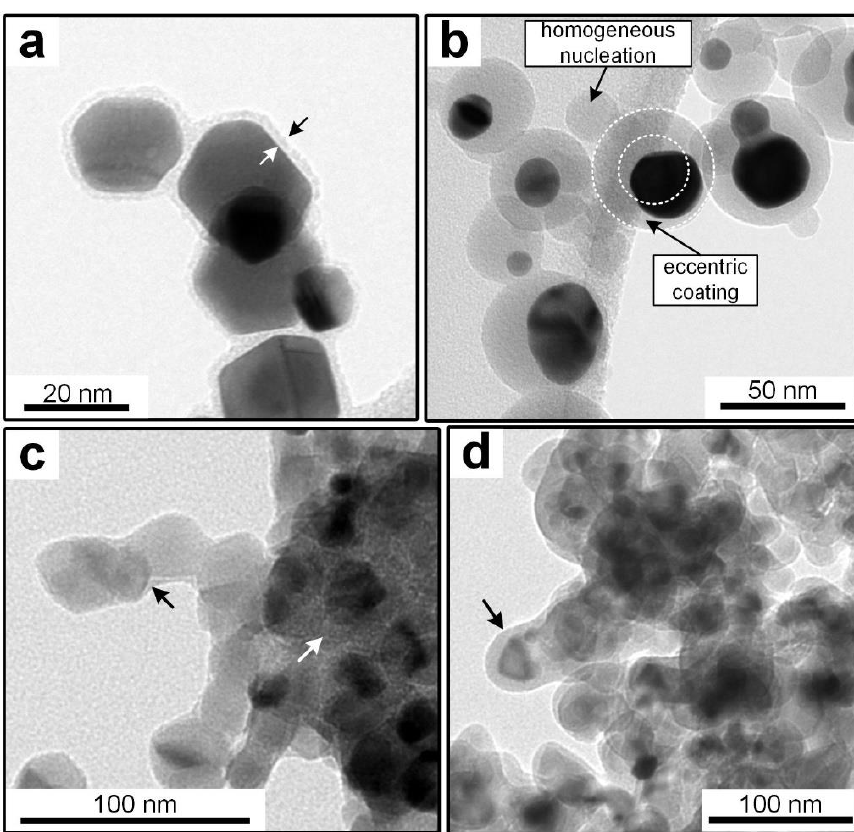
Figure 2. TEM micrographs of particles coated in the process. ( a ) Au, coated at 200 °C with TEOS; ( b ) Au, coated at 250 °C with HMDSO; ( c ) TiO 2 ; coated at 24 °C with TEOS; ( d ) TiO 2 , coated at 200 °C with TEOS.